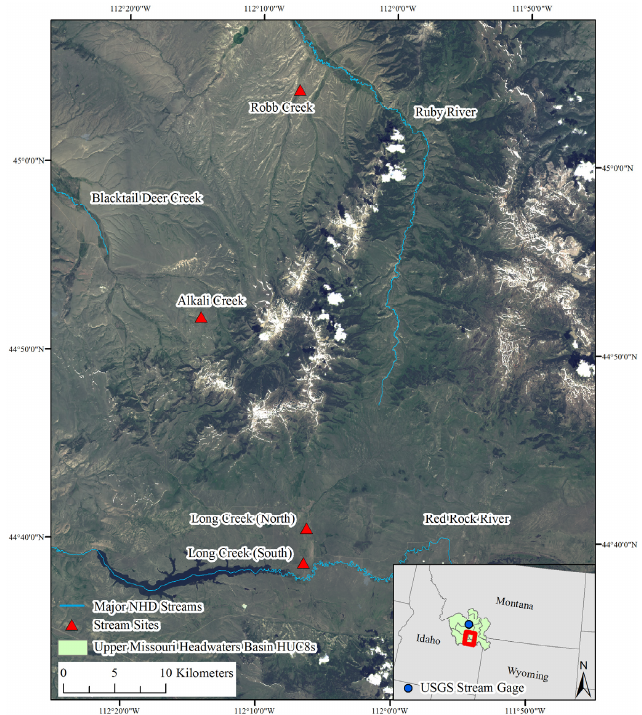
Figure 1. Distribution of the stream sites within the Upper Missouri Headwaters Basin. Background image is a Landsat 8 image (path 39, row 39, 9 June 2016). Location of the U.S. Geological Survey stream gage (Jefferson River, #06026500) is also shown relative to the restoration sites. NHD: National Hydrography Dataset, HUC8s: 8-digit Hydrological